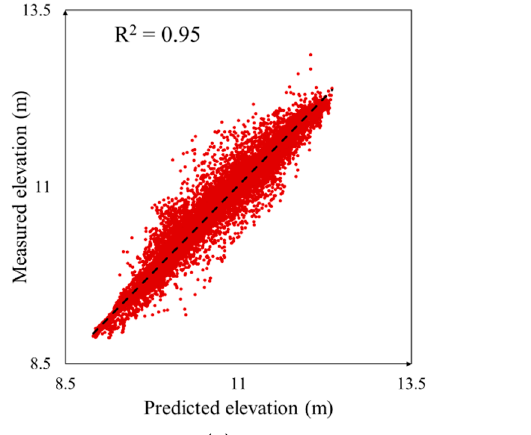
Table 2. Errors of the predicted riverbed elevation for the Baxter River